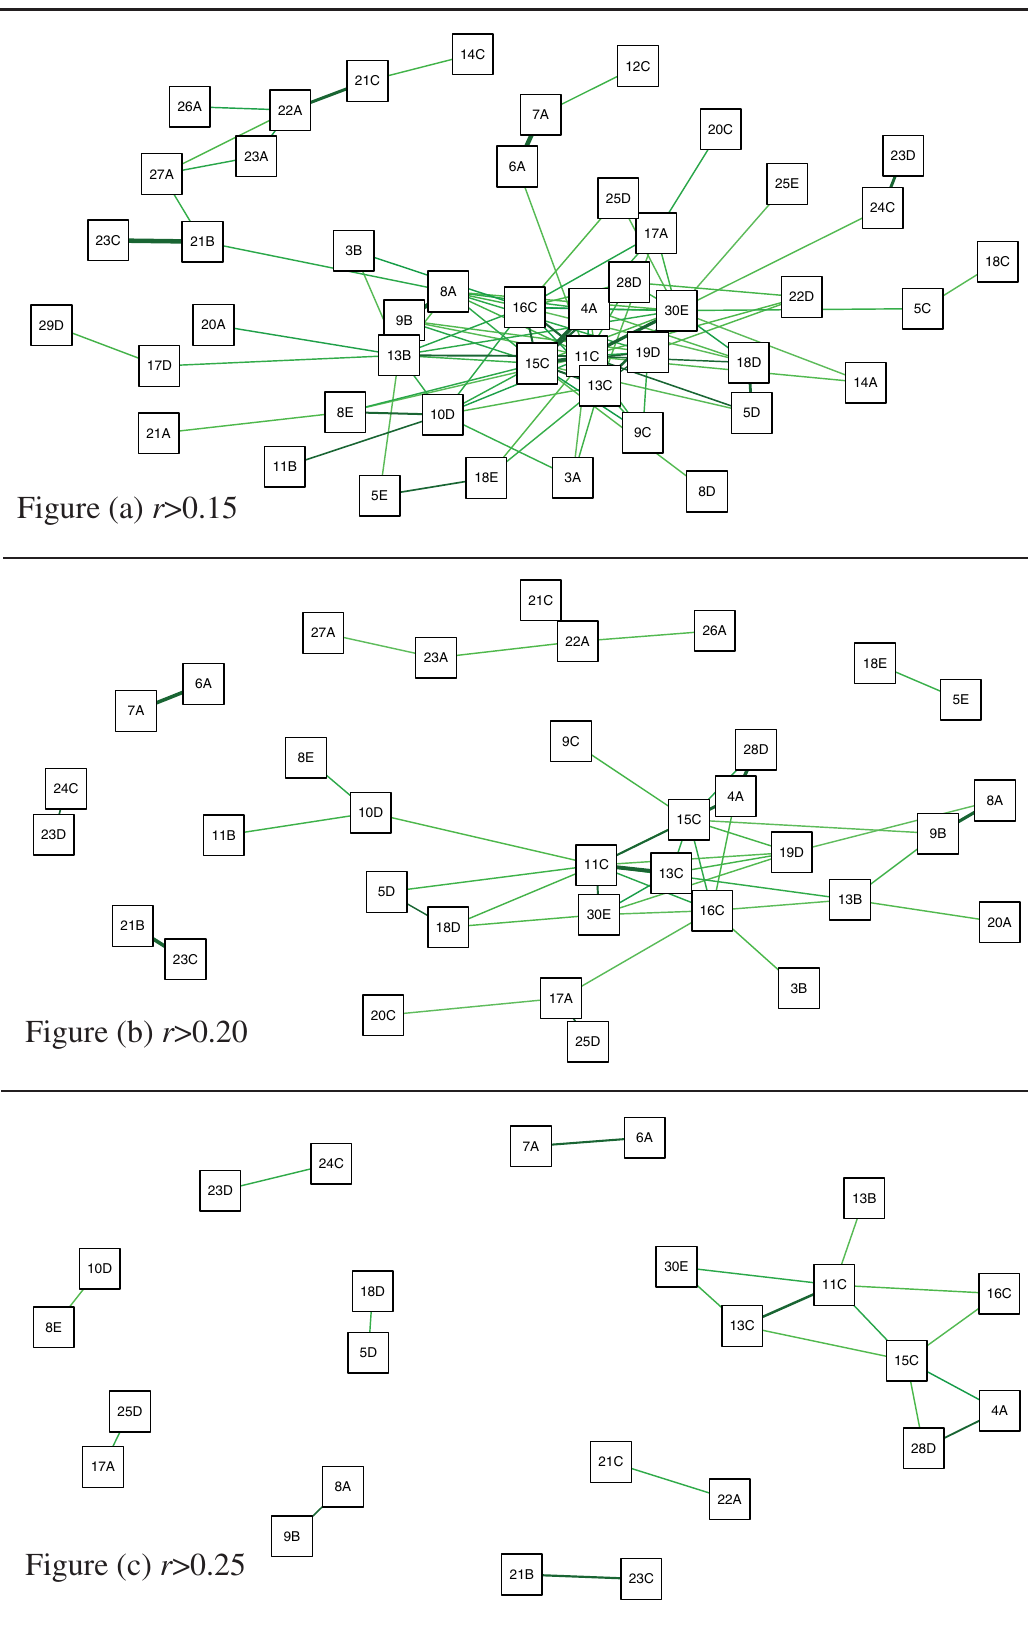
FIG. 4. Post-test correlation matrices of women at varying levels of r